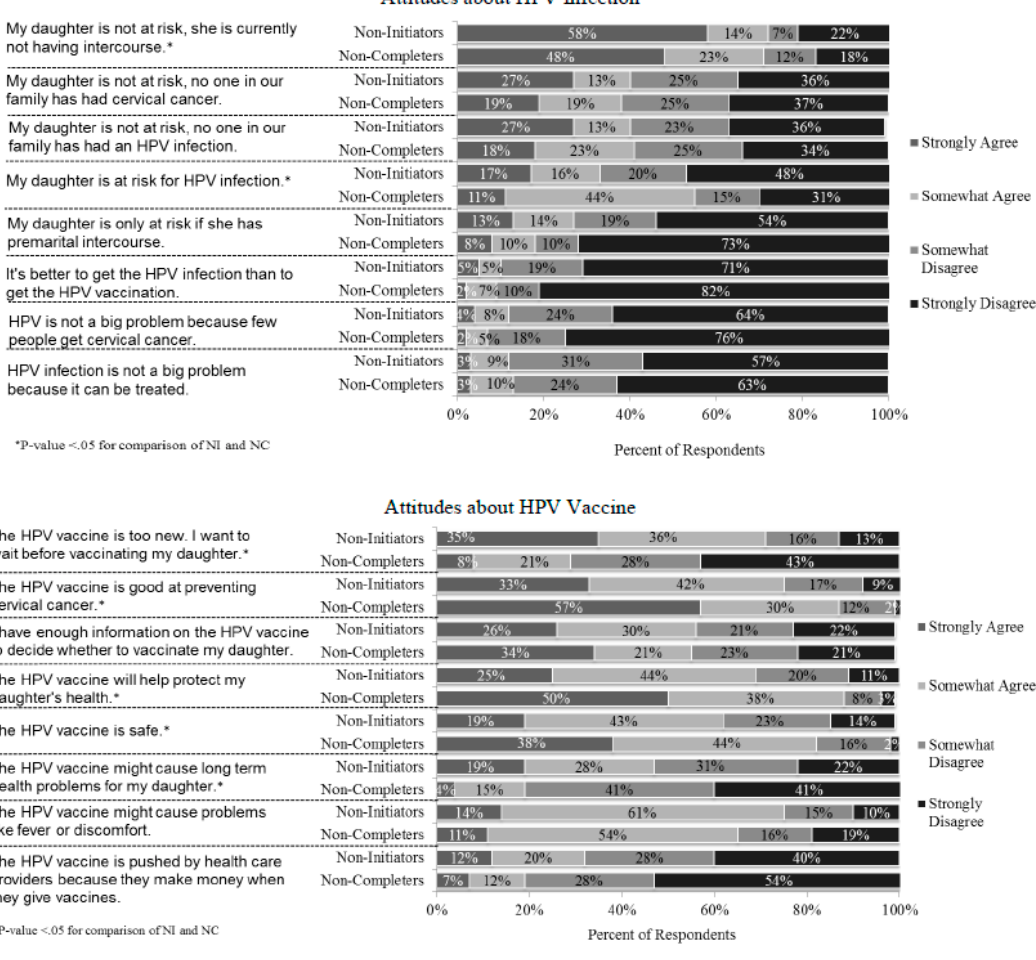
Figure 2. Attitudes about HPV infection and vaccination among parents whose daughters had not started or not completed the Human Papillomavirus (HPV) Vaccine Series. NI: not initiated; NC: not completed. Table 2. Importance of factors on decision to vaccinate with HPV Vaccine among parents who reported their daughters had never received HPV